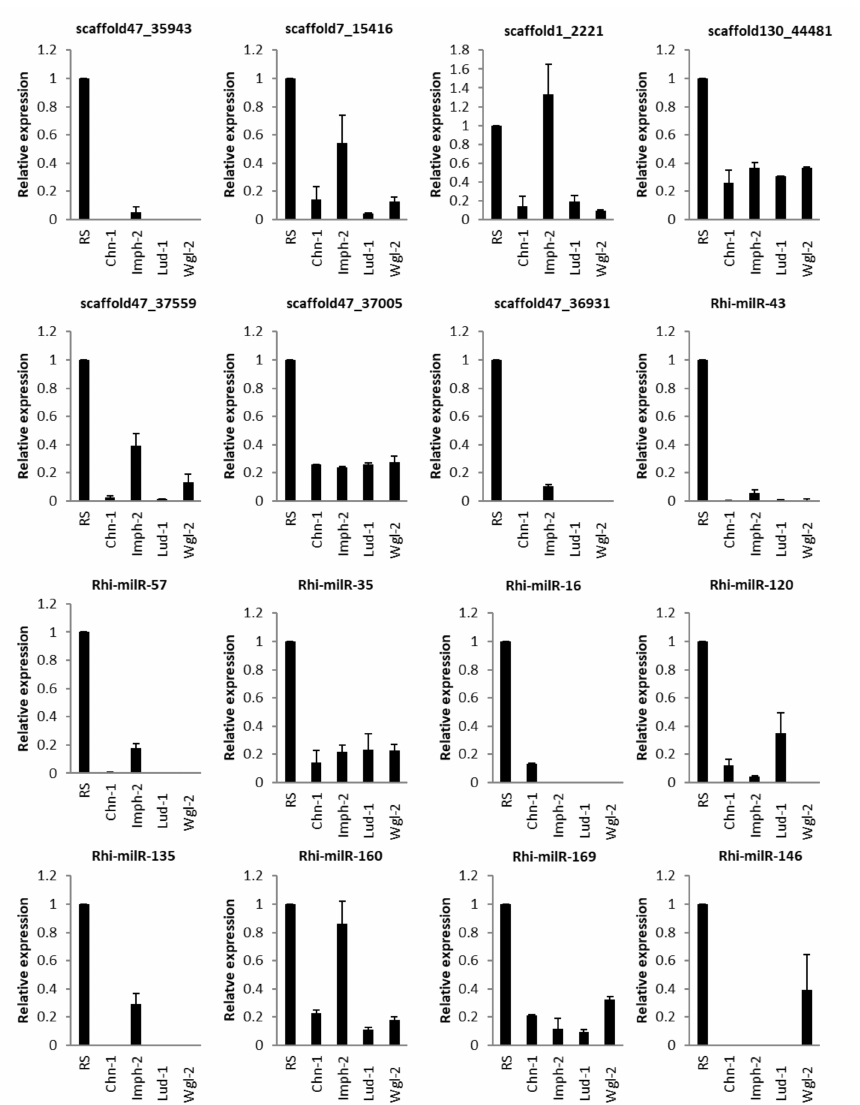
Figure 5. qRT-PCR expression analysis of milRNAs in sheath tissue of TN1 after inoculation with different strains of R. solani . X-axis: samples (sheath tissue of TN1 inoculated with four different strains of R. solani ); Y-axis: Expression level of the individual milRNA relative to its expression in R. solani grown in PDA. Error bars indicate the mean ±